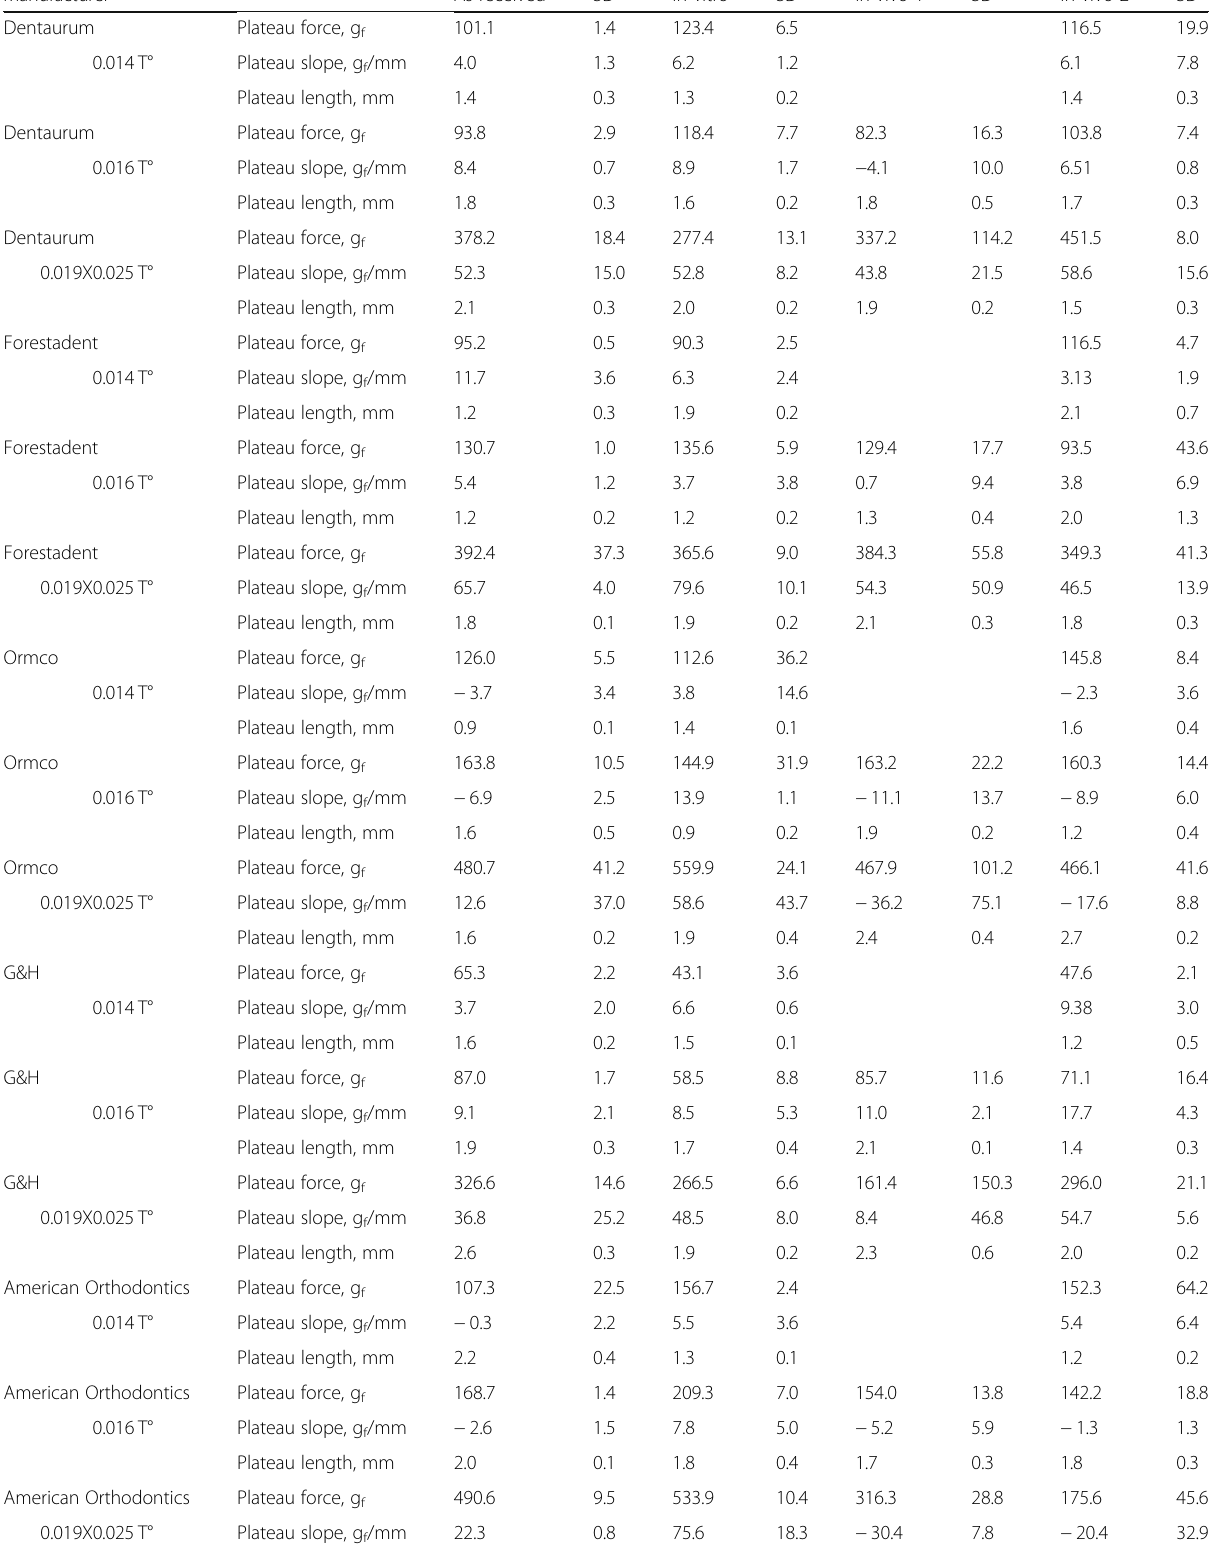
Table 3 The mean values yielded by as received and retrieved heat-activated orthodontic wires Manufacturer